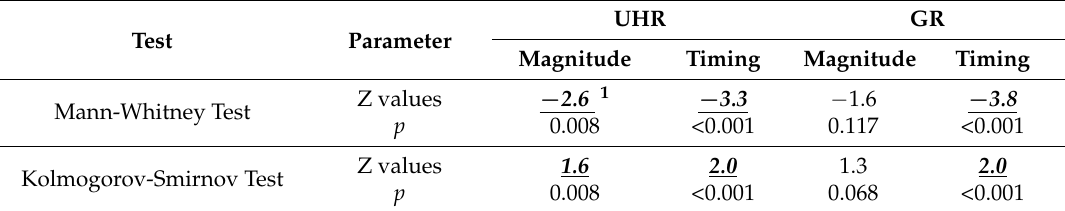
Figure 3. The box plot of T max and high flow magnitude in pairing reference and warming years in the UHR ( a ); and T a 6 and high flow magnitude in the GR ( b ) watersheds. Table 7. The Mann–Whitney and Kolmogorov–Smirnov tests on the differences in high flow magnitude and timing between the paired reference and warming years in the UHR and GR watersheds.